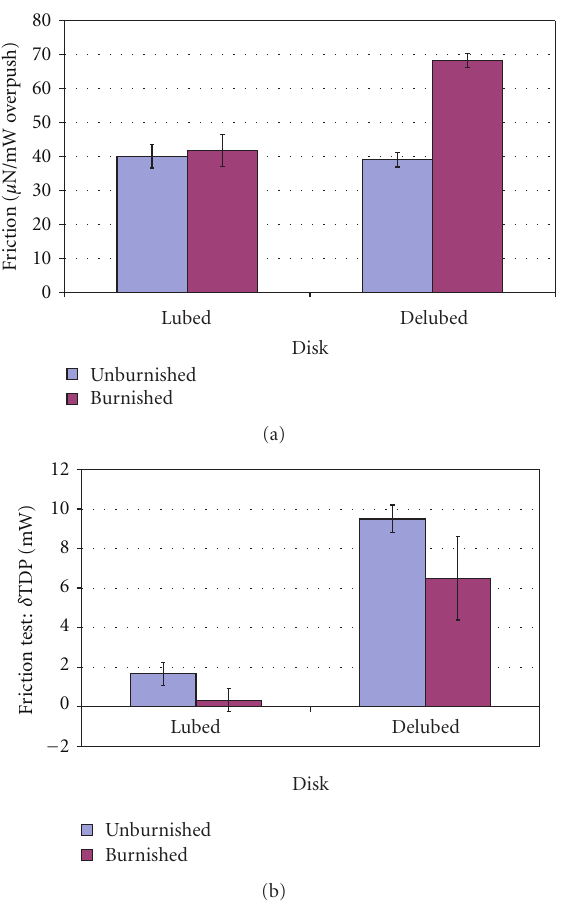
Figure 12: E ff ect of mobile lubricant on friction and slider burnishing.